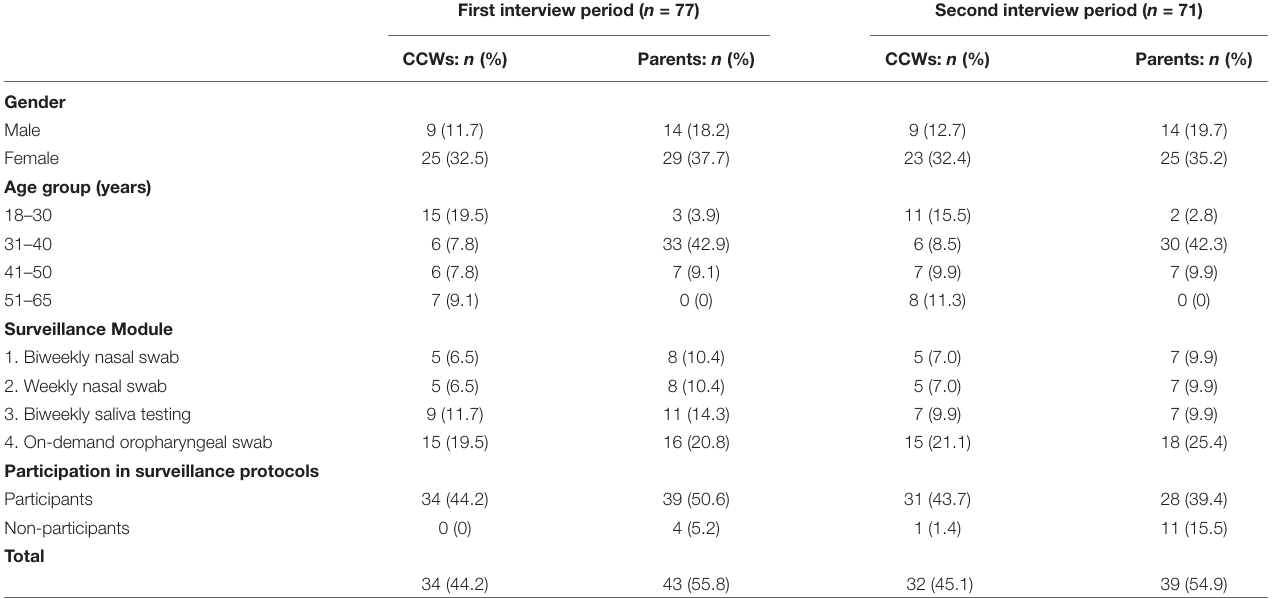
TABLE 2 | Participants’ characteristics.